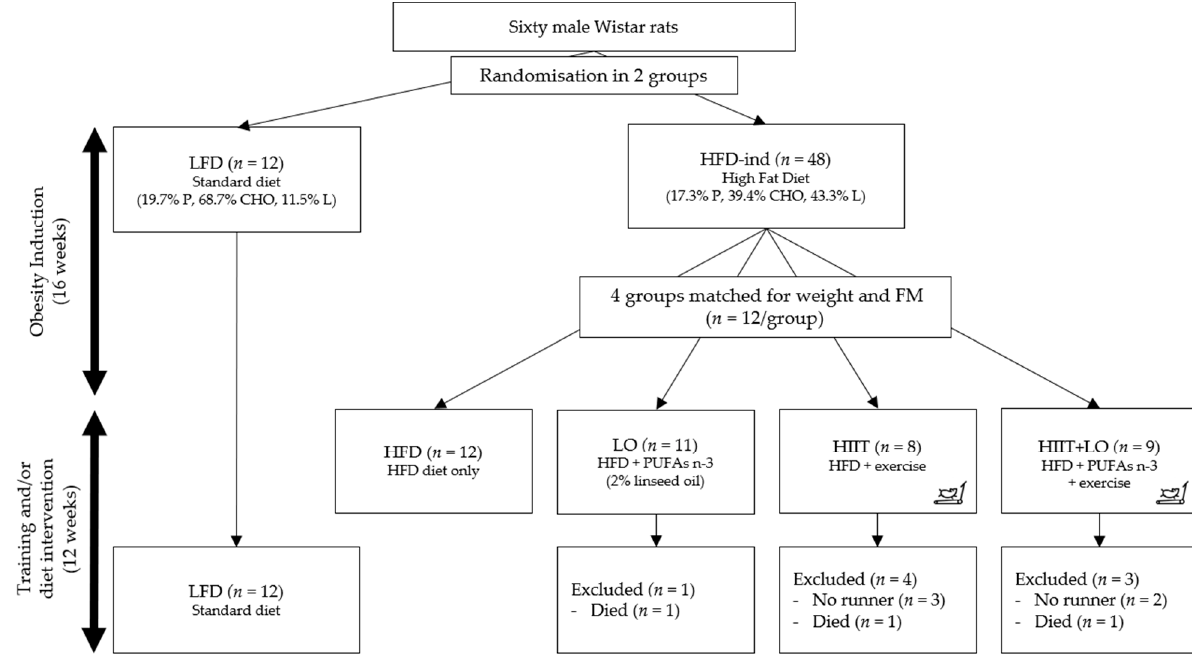
Figure 1. Study design. Rats were randomized in two groups: LFD ( n = 12) and HFD ( n = 48) for 16 weeks (phase 1). After this period, the HFD group was divided in four groups ( n = 12/group) matched for weight and fat mass: HFD, LO, HIIT, and HIIT + LO for 12 weeks (phase 2). In the HIIT and HIIT + LO groups, “no runner” rats were excluded from the study. LFD: low-fat diet, HFD-ind: high-fat diet induction, HFD: high-fat diet, LO: linseed oil, HIIT: high-intensity interval training, FM: fat mass, PUFAs: polyunsaturated fatty acids, P: proteins, CHO: carbohydrates, L: lipids.